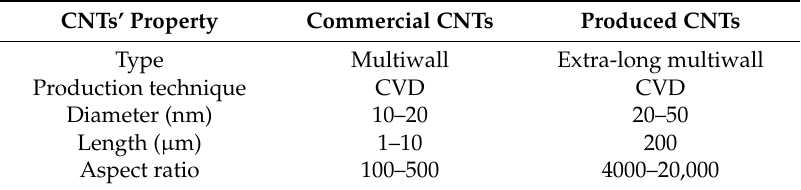
Table 1. Main properties of commercial and produced